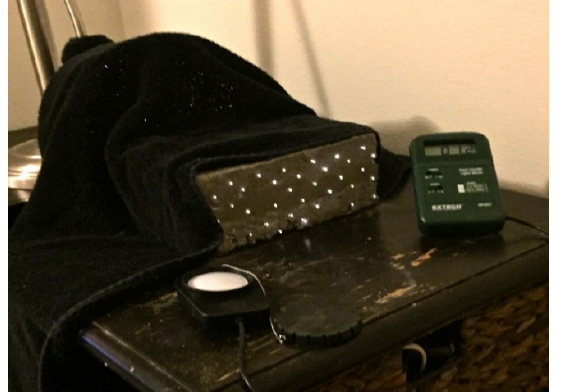
Fig. 16: Testing concrete blocks